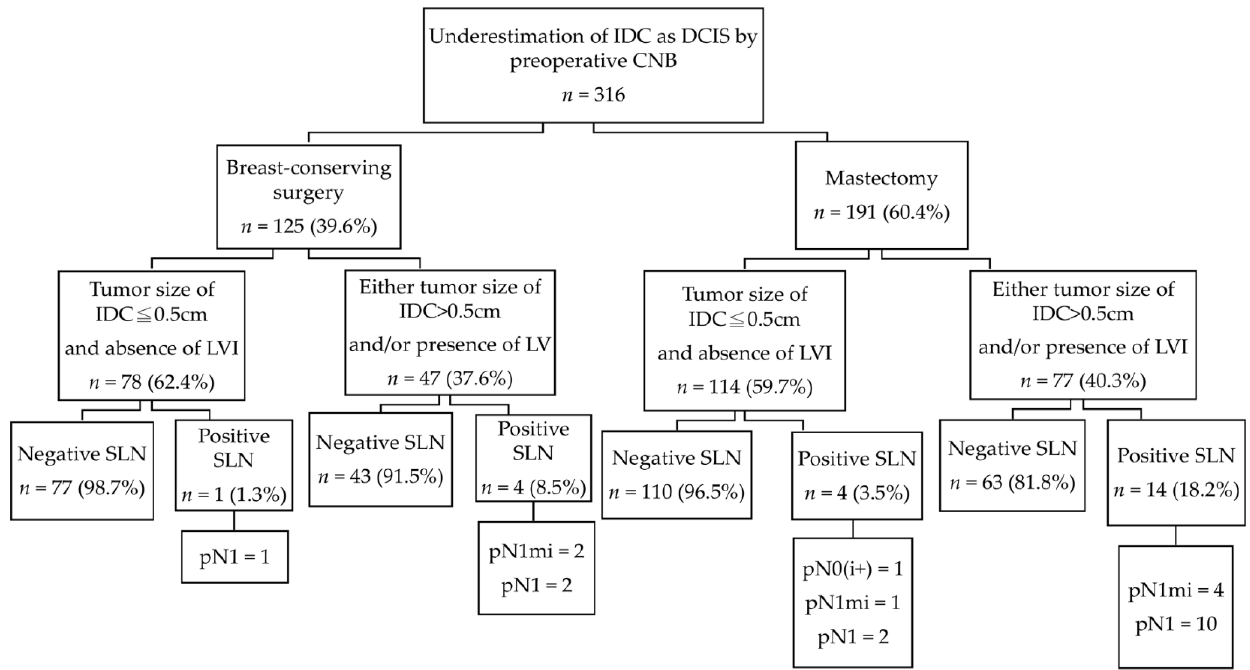
Figure 3. Results of sentinel lymph node biopsy according to different surgical procedures and the combination of tumor size of invasive ductal carcinoma ( (cid:53) 0.5 cm) and absence of lymphovacular invasion. IDC, invasive ductal carcinoma; DCIS, ductal carcinoma in situ; CNB, core needle biopsy; LVI, lymphovascular invasion; SLN, sentinel lymph node; pN0(i+), isolated tumor cells; pN1mi, micrometastasis; pN1, 1–3